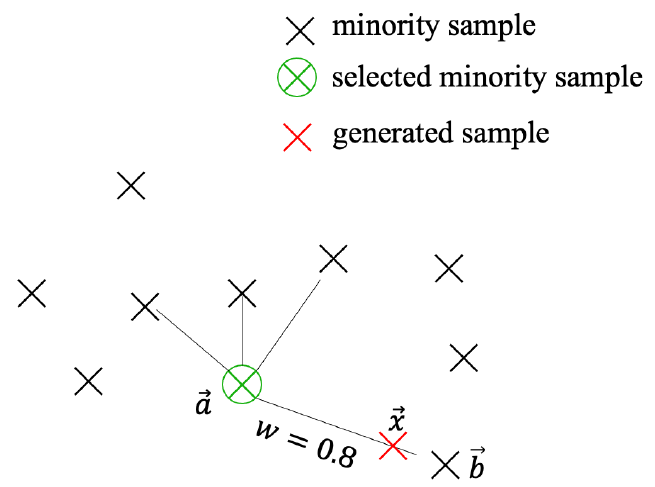
Figure 4. SMOTE linear interpolation of a random choose minority sample (k = 4 neighbors).